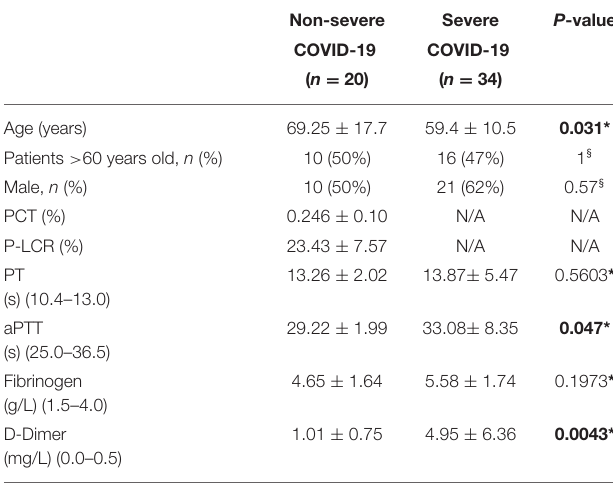
(MPV), platelet count-to-MPV ratio (PLT_MPV), activated TABLE 1 | Clinical characteristics of non-severe and severe patients with confirmed COVID-19 on